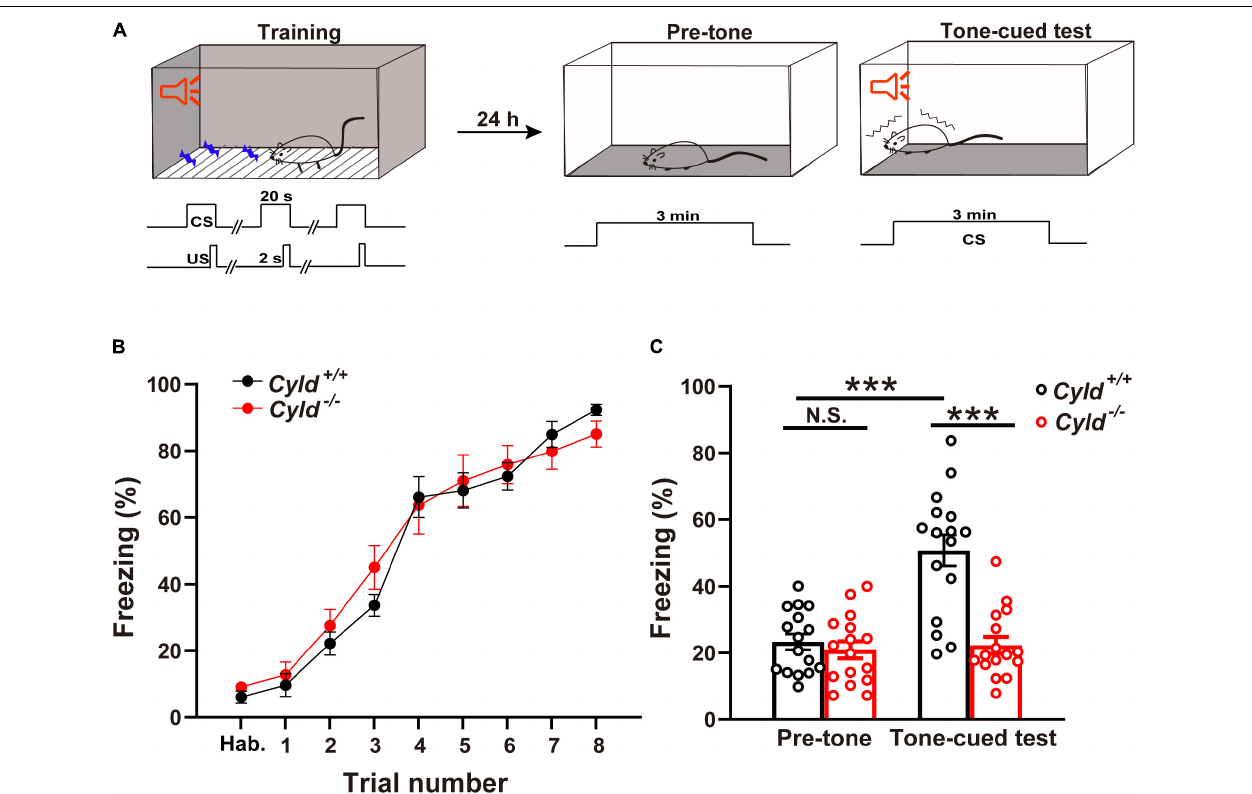
FIGURE 1 | Cyld knockout mice show impairment of tone-cued fear-conditioned memory. (A) Tone-cued fear conditioning diagram. Tone (CS)–shock (US) pairings were delivered eight times (US, 0.5 mA, 2 s) 18 s after the start of the tone during training in context A. Twenty-four hours later, mice were placed in context B for 3 min (pre-tone) and subsequently subjected to the 3-min tone-cued test in a different chamber. (B) Cyld knockout did not affect the acquisition phase of fear memory. Cyld − / − and Cyld + / + mice showed a similar freezing response during the habituation (Hab.) and training period. (C) The freezing response of Cyld − / − mice was reduced in the tone-cued test. For each group, n = 16 mice. Two-way ANOVA, *** p < 0.001; N.S., not